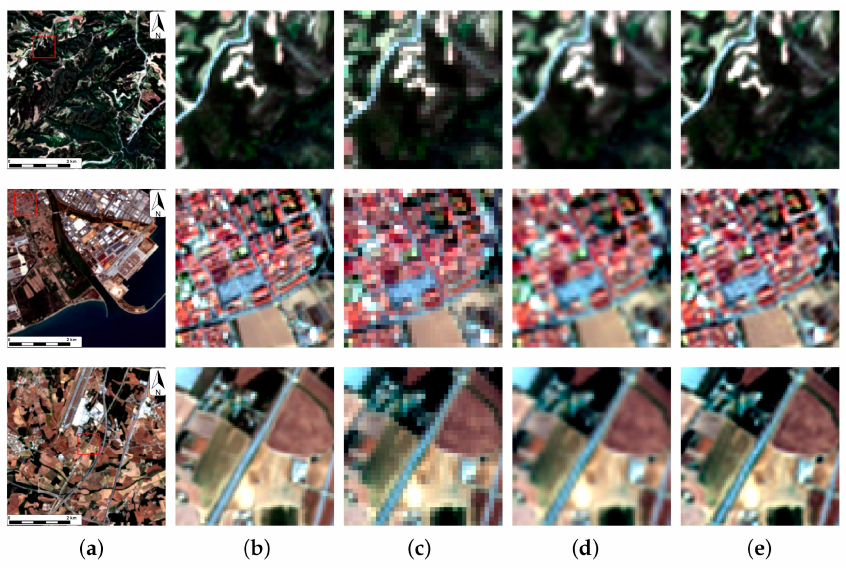
Figure 8. SISR results obtained with model v 4 using Pixel Shuffle: ( a ) full ground truth image, ( b ) selected crop downsampled to 20 m to form the LR pair, ( c ) Nearest Neighbor interpolation of LR crop, ( d ) bicubic interpolation of LR crop, ( e ) SISR